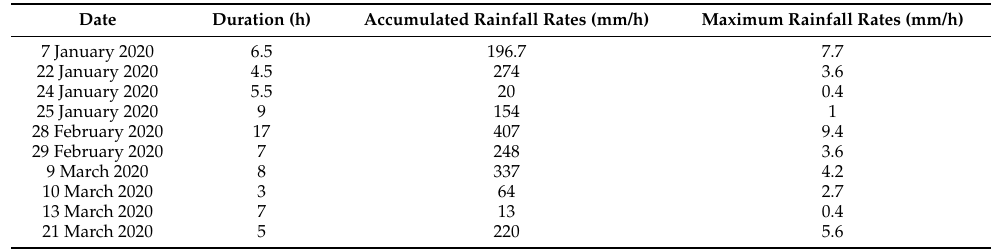
Table 2. Date, duration (in hours), rain amount (in millimeters), and maximum rainfall rate (in millimeter per hour) of the considered rain